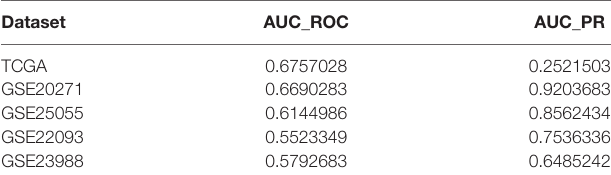
TABLE 5 | Comparing the resistant group and the sensitive group, the immune- related characteristics are downregulated. Dataset